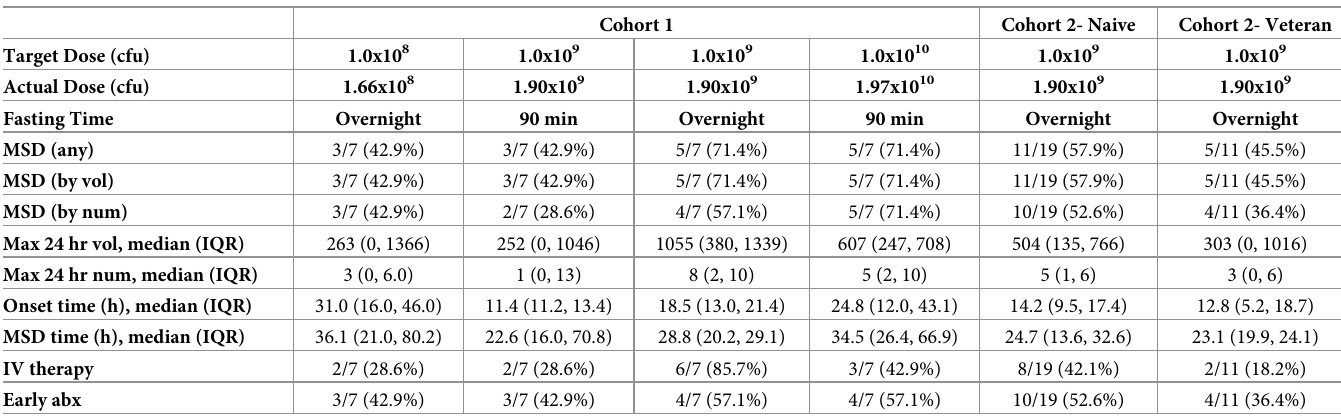
Table 1. Clinical outcomes by